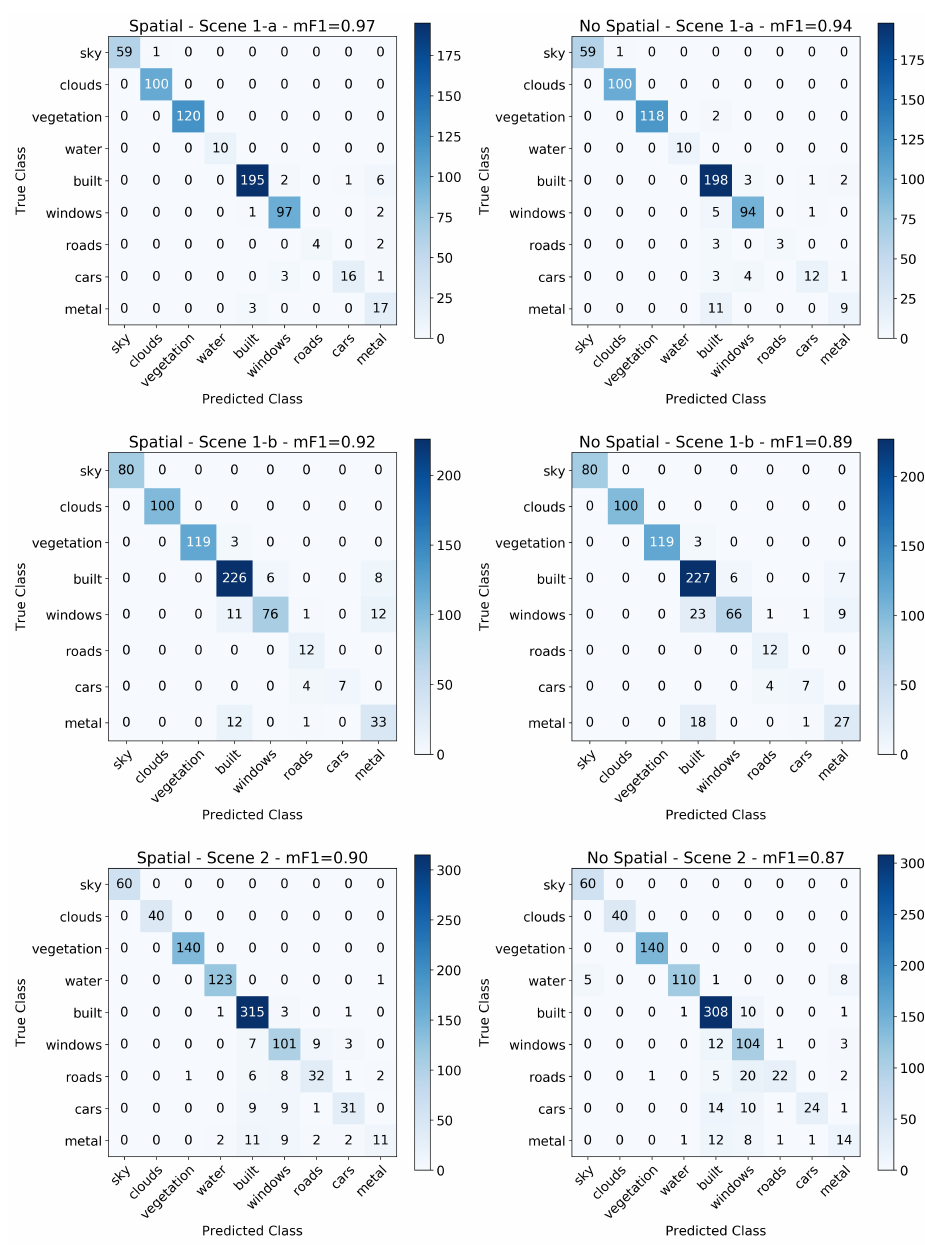
Figure A2. Confusion matrices used to derive the metrics in Table 2 for the classification of hand-labeled pixel spectra using Model 2 with ( left ) and without ( right ) the spatial features included for each scene